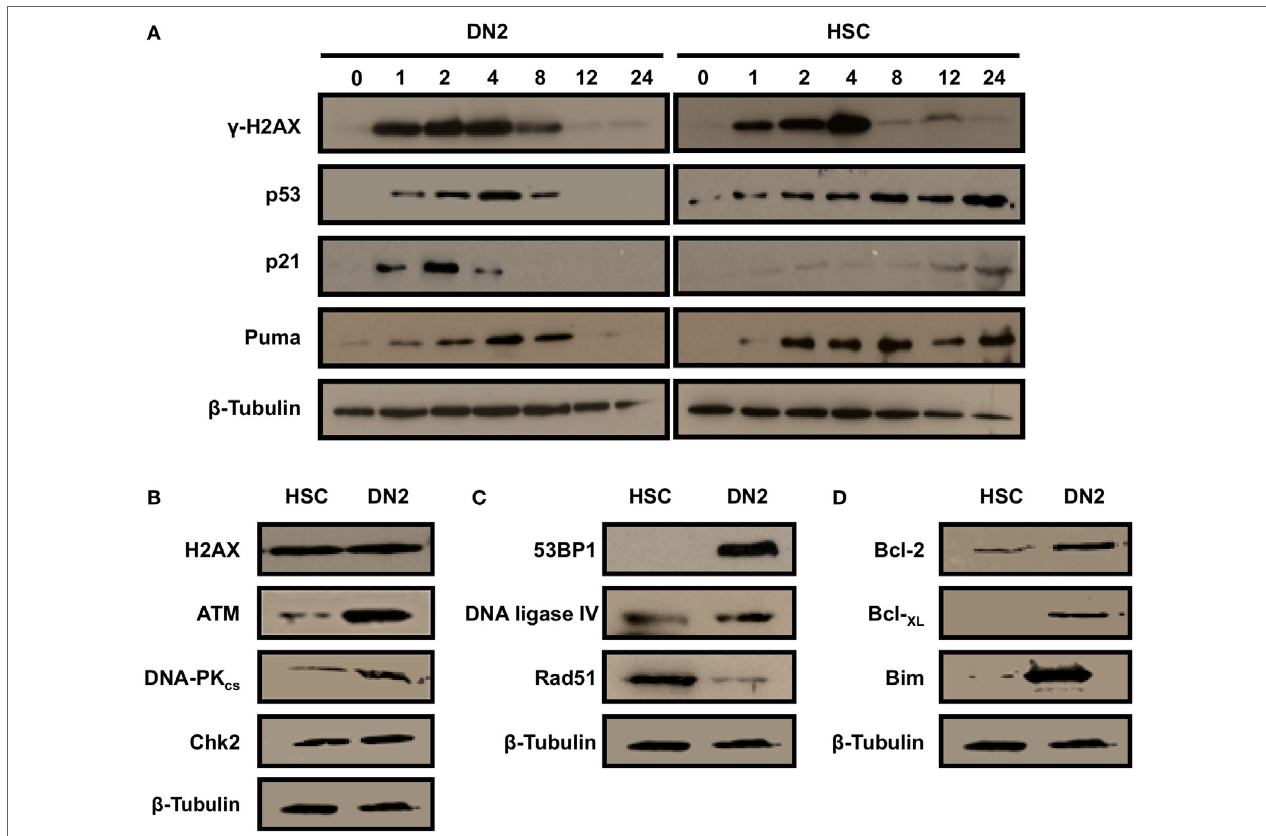
FigUre 3 | DN2 thymocytes activate a robust DNA damage response following γ -irradiation. Western blot analysis of (a) H2AX (Ser139) phosphorylation ( γ H2AX—marker of DNA double-strand breaks), p53 stabilization; and p21 and Puma expression in DN2 cells and NH-hematopoietic stem cells (HSCs) at 0–24 h post 4 Gy irradiation. Western blot analysis of total endogenous levels of (B) of H2AX, ATM, DNA-PKcs and Chk2; (c) of 53BP1, DNA ligase IV and Rad51; and (D) of Bcl-2, Bcl-XL, and Bim in un-irradiated (control) DN2 cells and NH-HSCs. β -Actin and β -tubulin were used as internal controls. All images are representative of one of three independent